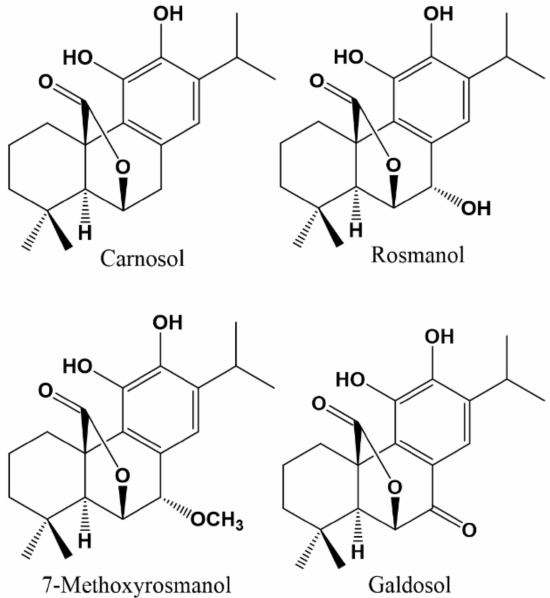
Figure 5. Chemical structures of active phenol-diterpenes on GABA A